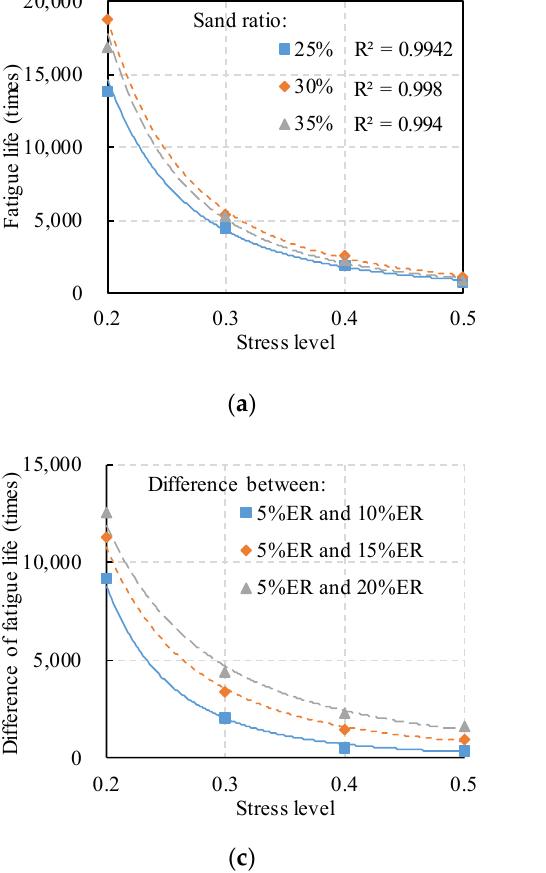
Figure 5. Effect of stress level on the fatigue life of ER–PC: ( a ) 5% ER content; ( b ) sand ratio of 25%; ( c ) sand ratio of 30%; ( d ) sand ratio of 35%. Table 5. Fitting results of σ - N fatigue equation.